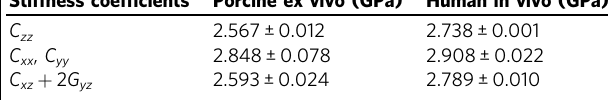
Mean±standard deviation from four samples in each